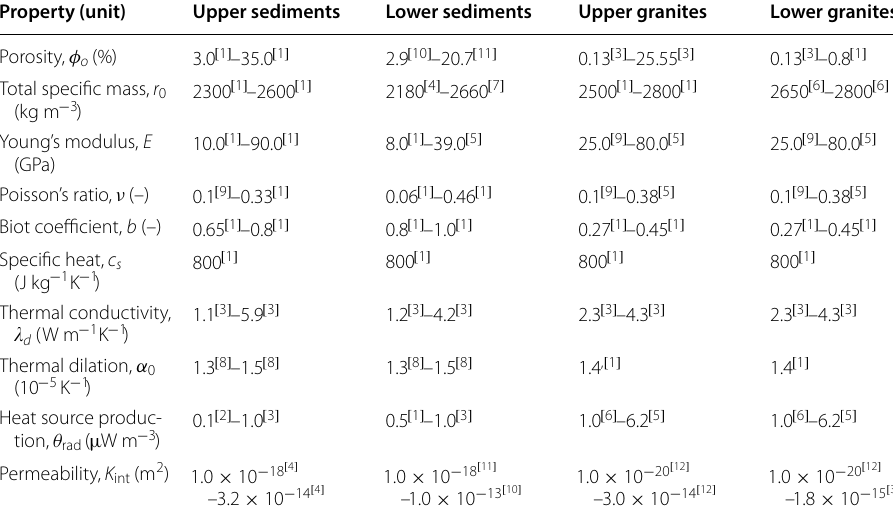
Table 1 Typical rock properties according to: (1) Magnenet et al. (2014); (2) Kohl (2000); (3) GeORG); (4) Bar (2012); (5) Rummel (1992); (6) Haenel (1983); (7) Freymark et al. (2017); (8) Kirk and Williamson (2012); (9) Sausse (2002); (10) Heap et al. (2017); (11) Griffiths et al. (2016); (12) Hettkamp et al.